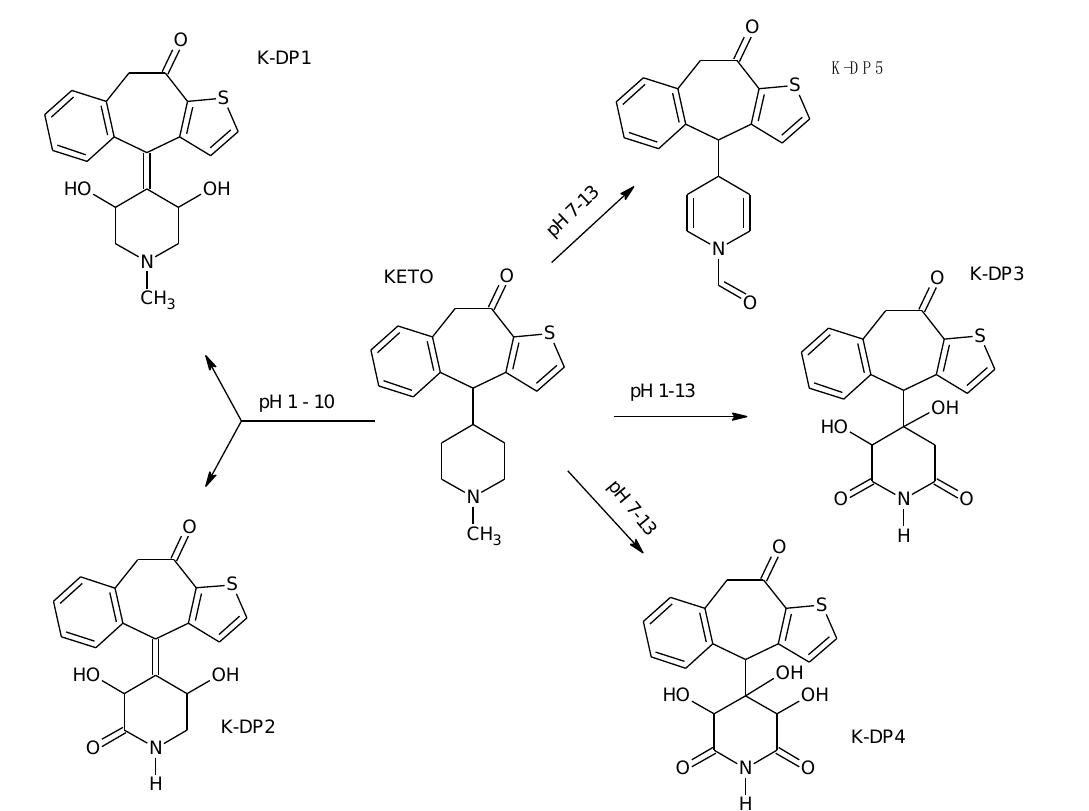
Figure 7. Proposed degradation pathways of ketotifen (KETO) in different pH conditions at 70 °C.